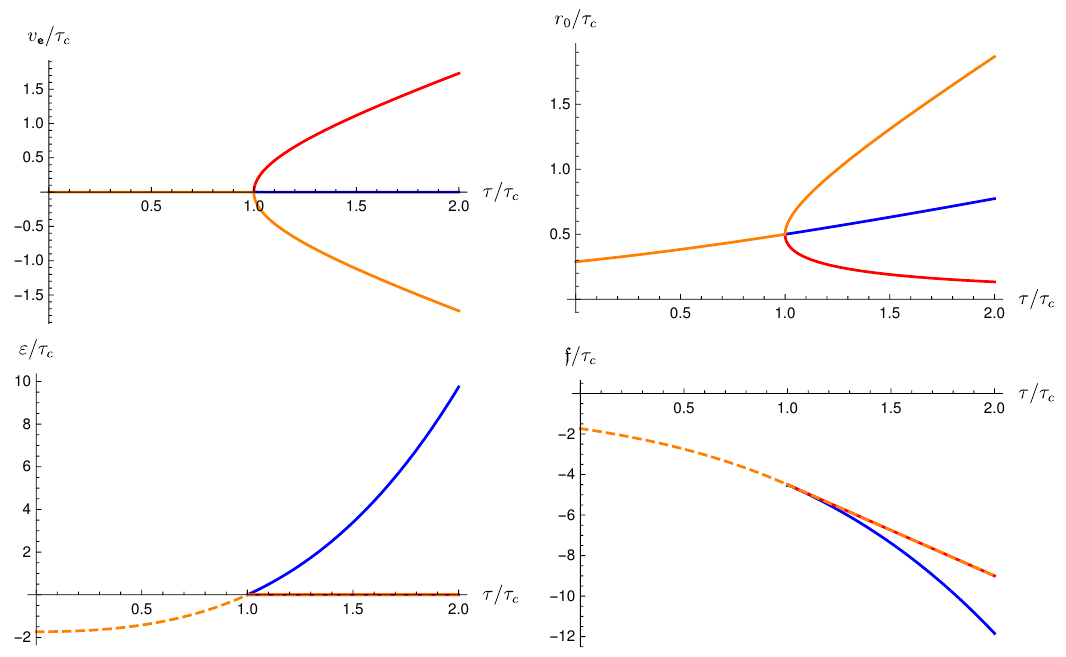
Figure 1 . Plot of the perturbative solutions (6.17) for (cid:26) = 0 : 003 (cid:26) c , together with the corresponding energy " and Helmholtz free energy f